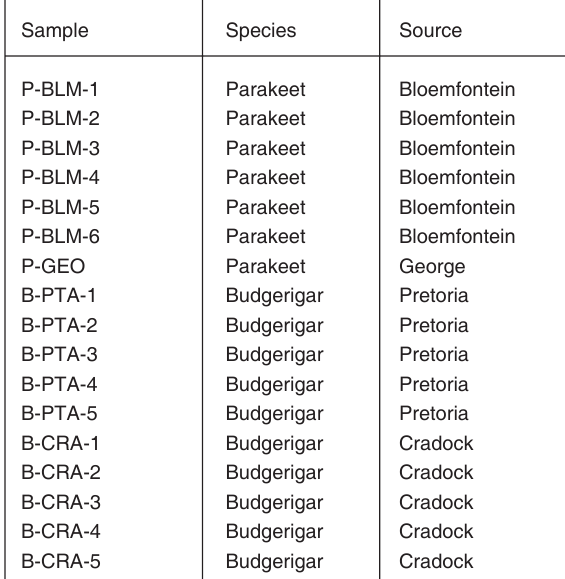
TABLE 1 Blood samples obtained from species and